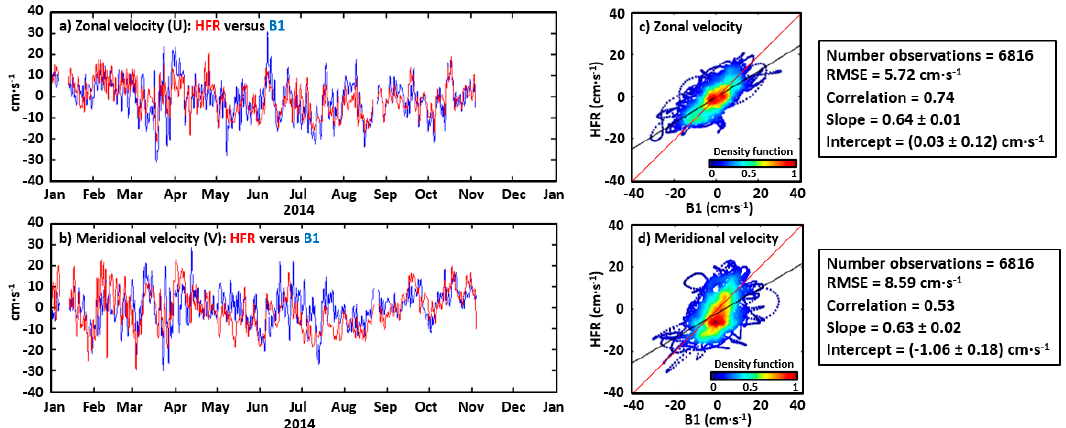
Figure 2. Annual (2014) comparison of zonal ( a , c ) and meridional ( b , d ) hourly surface current velocities observed by B1 buoy and HFR (at the closest grid point): 30-h low-pass filtered time series ( a , b ) and best linear fit of scatter plots ( c , d ). Skill metrics gathered in black boxes.